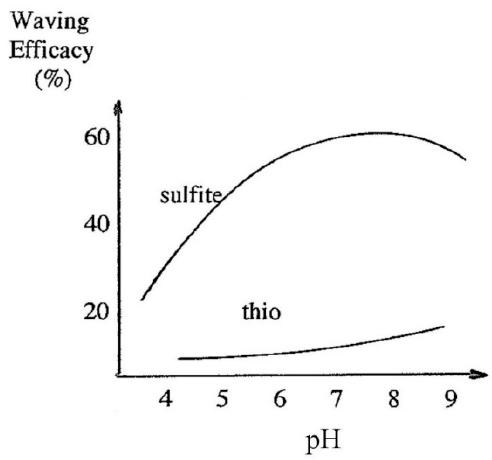
Figure 30. Waving efficacy of hair without peroxide neutralization [21].